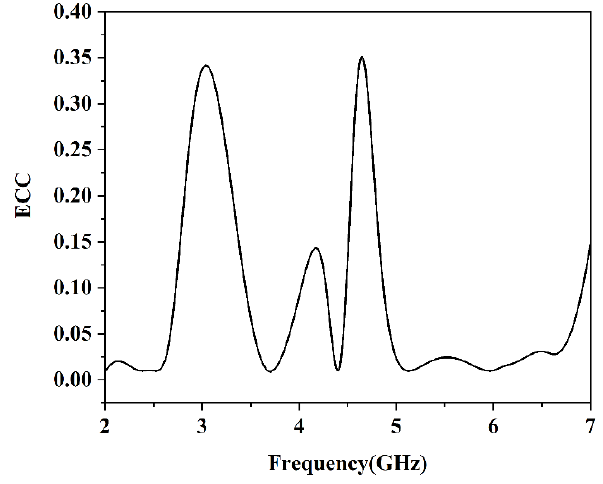
Figure 11. Calculated ECC of the MIMO antenna system. In Table 3, the operating frequency band, minimum isolation, peak gain and size of the proposed antenna are compared with some recently reported dual-band MIMO antennas.